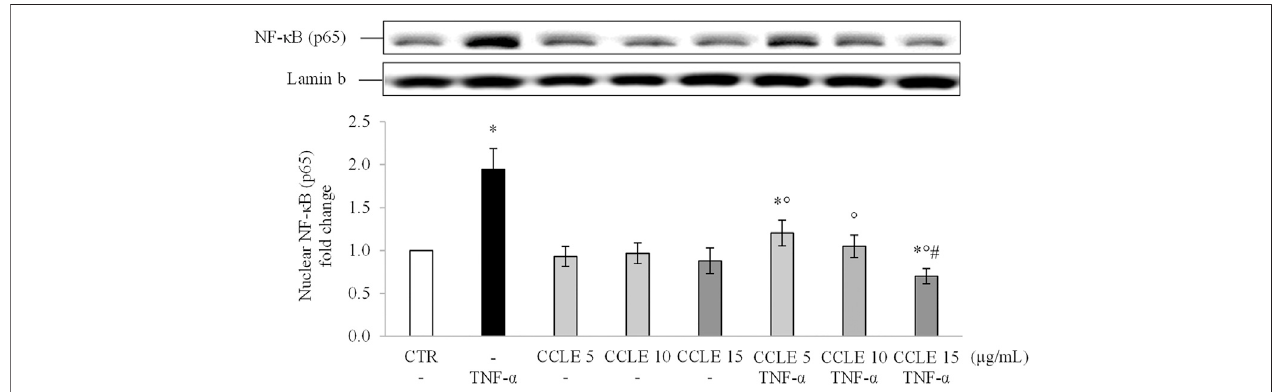
FIGURE 1 | Nuclear NF- κ B (p65). The Caco-2 monolayer was pretreated with CCLE (5, 10, and 15 μ g/ml) for 24 h, and subsequently exposed to 50 ng/ml TNF- α for 6 h. Cultures treated with the vehicles alone were used as controls (CTR). Caco-2 nuclear lysates were analysed by Western blot, and nuclear localization of the p65 protein was evaluated. NF- κ B (p65) intensity values were normalized to the corresponding Lamin B values. Results are reported as fold change against CTR and expressed as mean ± SD of three independent experiments. * p < .05 vs CTR; ° p < .05 vs TNF- α ; # p < .05 vs lower doses of CCLE + TNF- α .